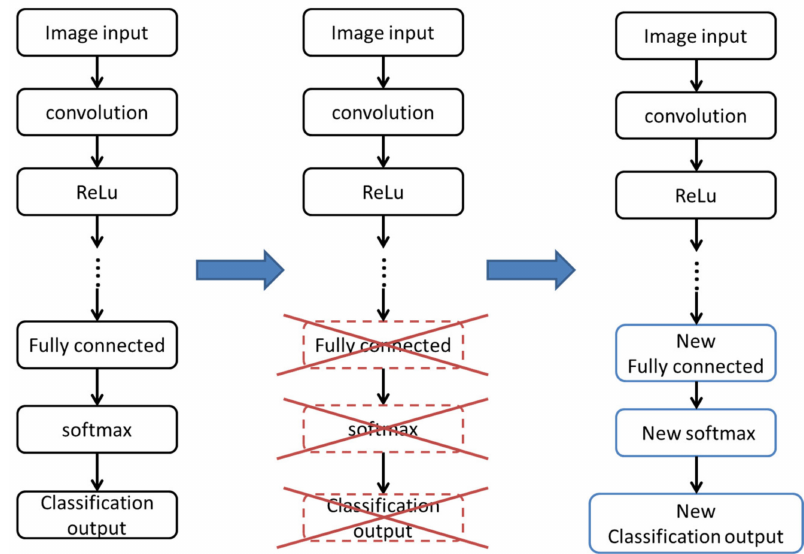
Figure 5. Illustration of transferred convolutional neural